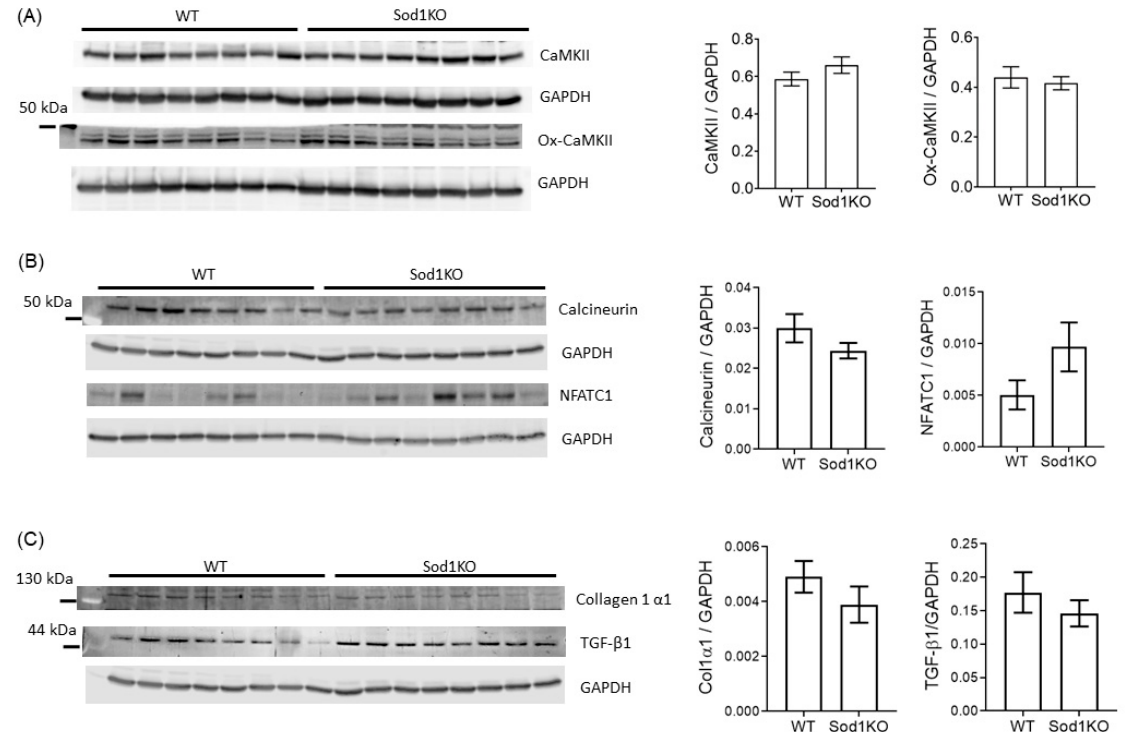
Figure 6. Lack of hypertrophic and fibrotic response in Sod1KO hearts. ( A ) Left: Immunoblot images showing total and oxidized CaMKII. Right: Quantified total CaMKII and oxidized CaMKII (ox-CaMKII), normalized to GAPDH ( n = 8). ( B ) Left: Immunoblot images showing calcineurin and NFATc1. Right: Quantified optical densities for calcineurin and NFATc1, normalized to GAPDH ( n = 8). ( C ) Left: Immunoblot images showing collagen1 α 1 and TGF- β 1. Right: Quantified optical densities for collagen1 α 1 and TGF- β 1, normalized to GAPDH ( n = 8). Data are mean ± SEM. Abbreviations: CaMKII = Ca 2+ /calmodulin-dependent protein kinase II; NFATC1 = nuclear factor of activated T-cells cytoplasmic; Col1a1 = collagen type I alpha 1 chain; TGF- β 1 = transforming growth factor- β 1.